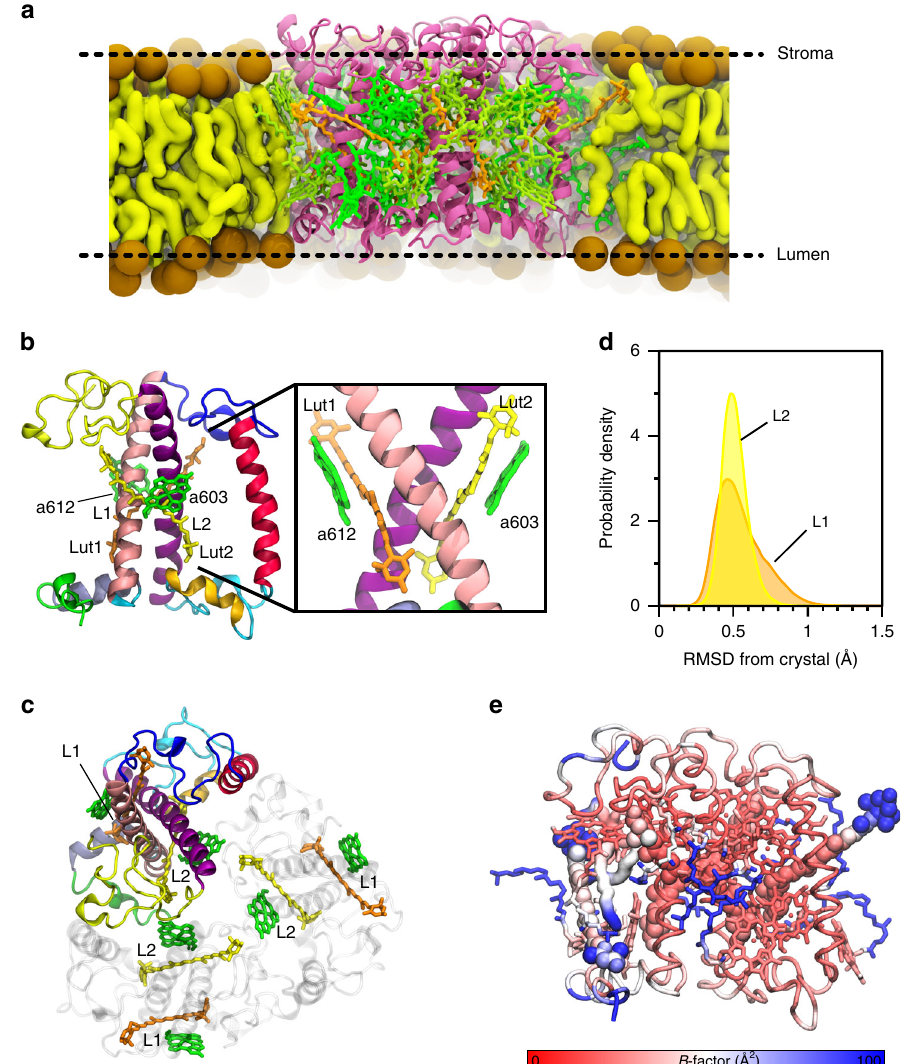
Fig. 1 Structure and dynamics of LHCII. a Positioning of trimeric LHCII in the phospholipid membrane. b View of the LHCII monomer from the membrane side, highlighting pigments of the L1 and L2 sites. The upper part corresponds to the stromal side. The inset shows a side view of sites L1 and L2. c View of the LHCII trimer from the stromal side, showing the pseudo-symmetrical arrangement of L1 and L2 sites. d Distribution of RMSD values from the crystal structure for the Lut – Chl pairs Lut1/ a612 in site L1 and Lut2/ a603 in site L2. e Monomer of LHCII colored by B factor (from red to blue, 0 – 100 Å 2 ). The protein backbone is shown as tubes, chlorophylls as sticks, and xanthophylls are shown as Van der Waals spheres, while DPPG is represented as the